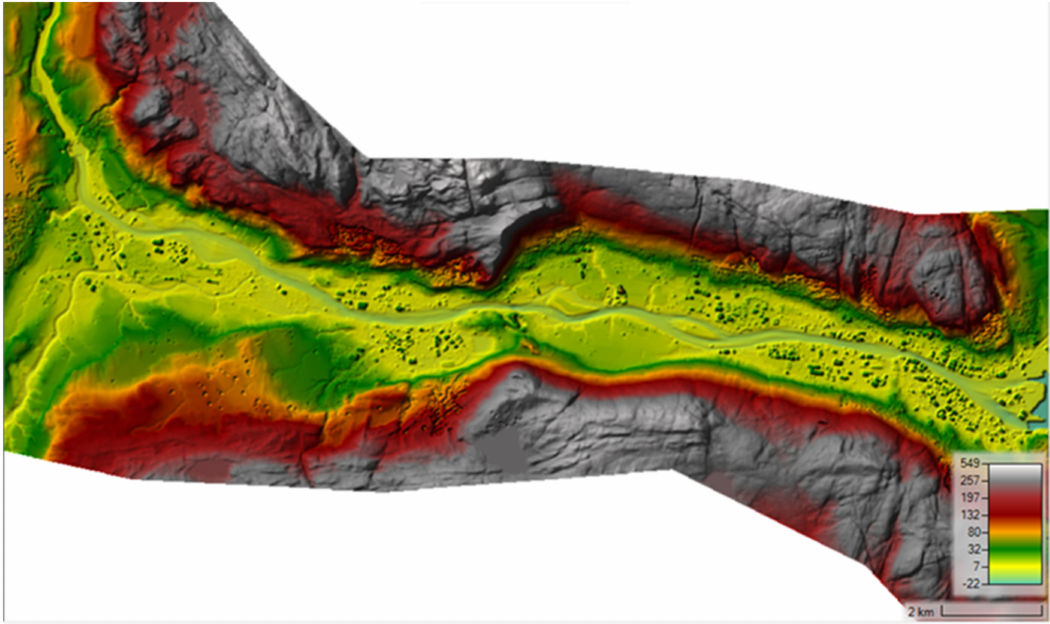
Figure 2. Terrain created by merging 1D geometry and red Lidar